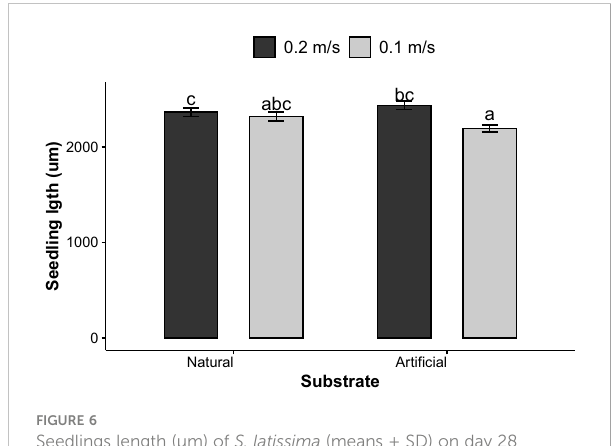
FIGURE 6 Seedlings length (µm) of S. latissima (means ± SD) on day 28 according to the substrate (natural vs. arti fi cial) and water velocity (0.1 m s -1 vs. 0.2 m s -1 ); bars with different letters are signi fi cantly different (p< 0.05), n = 6 .